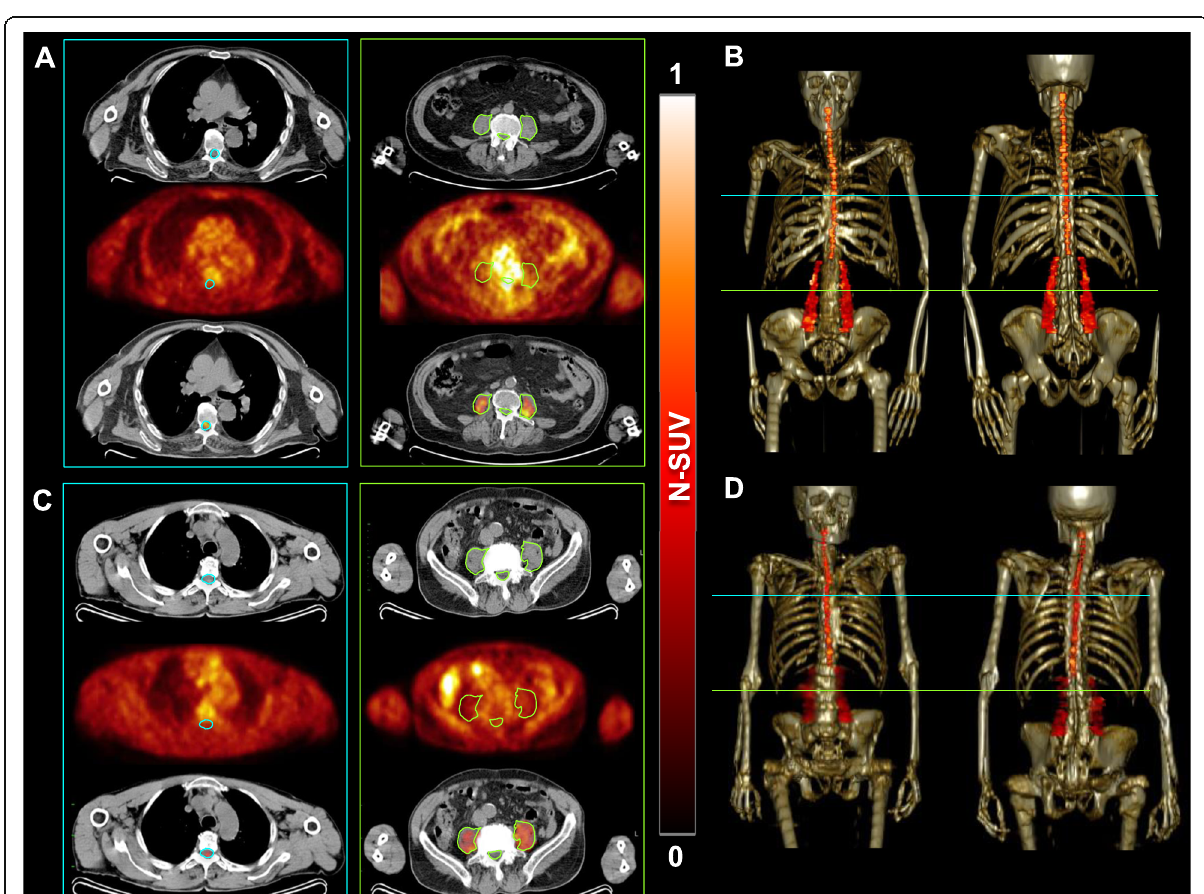
Fig. 1 Examples of psoas muscle extraction from PET/CT images. Computational extraction of the spinal cord and psoas regions of interest from axial FDG PET/CT images in ALS patient ( a ) and healthy control ( c ). In panels b and d , the 3D reconstruction of obtained volumes of interest on the skeleton of these subjects are